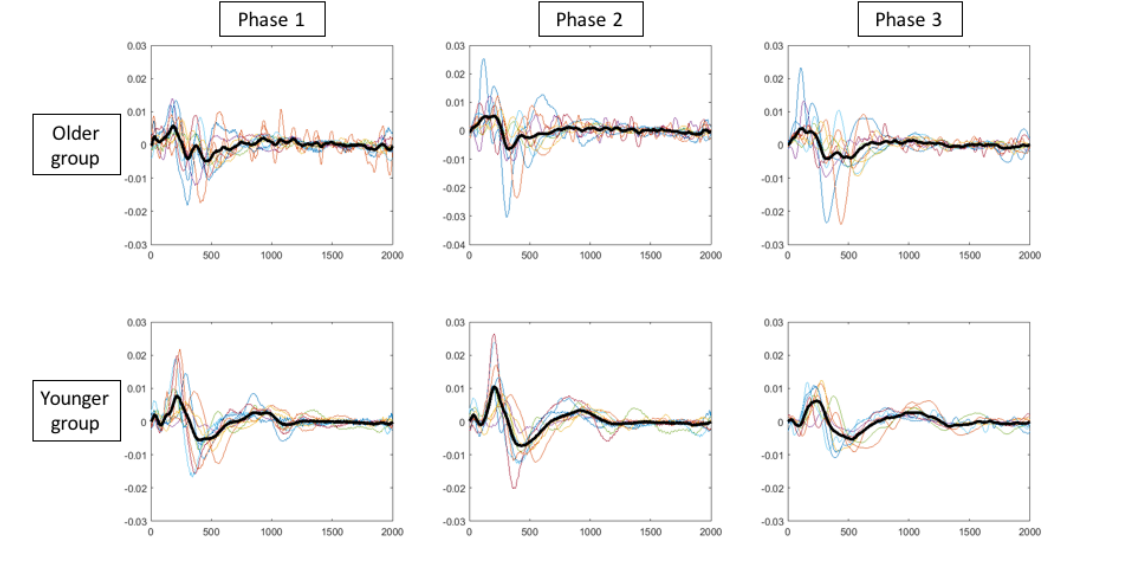
Fig. 4: The ensemble averages of –d 2 Z/dt 2 for each individual within each phase (colored lines). The mean of these curves is shown in the thick black lines (grand ensemble